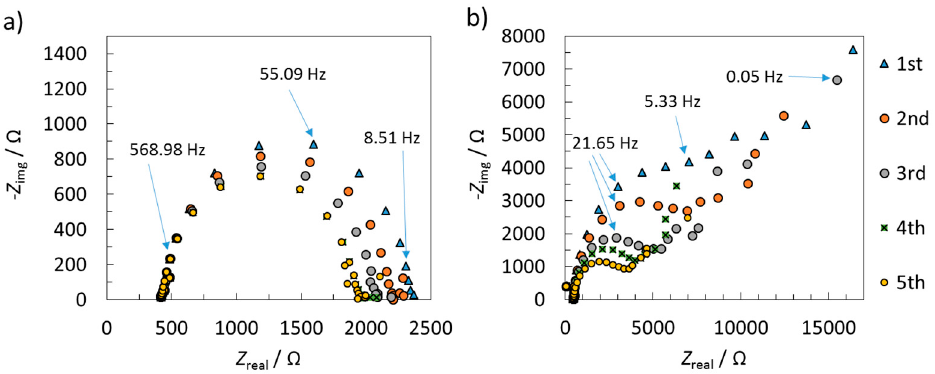
Figure 6. Successive EIS measurements for ( a ) SbFSPE and ( b ) bare SPE. EIS measurements were performed at − 1.1 V after a pre-concentration step ( E acc = − 1.1 V, t acc = 60 s) in 0.01 M HCl containing 169.1 µg/L Pb(II). In the case of SbFSPE a 0.5 mg/L Sb(III) was employed.